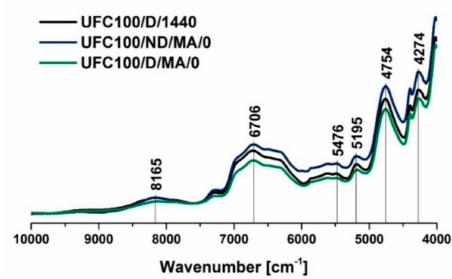
Figure 6. Near Infrared Spectroscopy (NIR) spectra of cellulose fibers modified via a regular approach (MA treatment) and unmodified. Characteristic absorption bands: 8165 cm − 1 (C–H), 7290 cm − 1 (C–H), 6772 cm − 1 (O–H), 6706 cm − 1 (O–H, water), and 4754 cm − 1 (O–H).